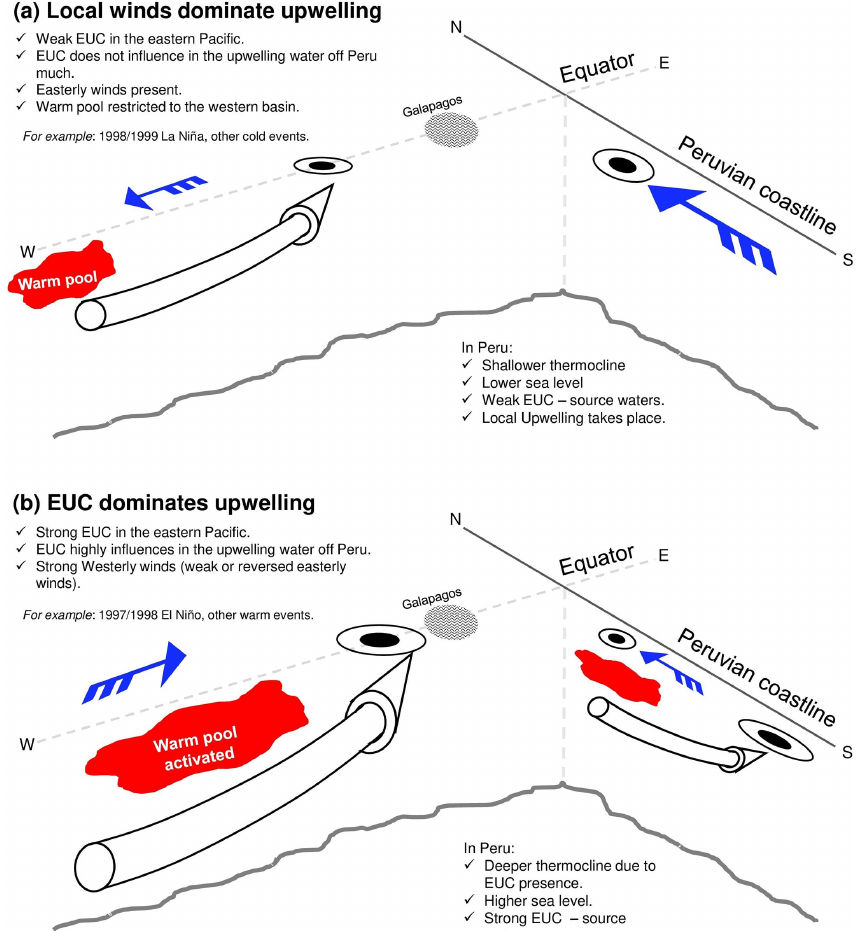
Figure 9. Schematic drivers and processes associated with the Peruvian upwelling system: (a) dominated by local winds; (b) dominated by EUC source